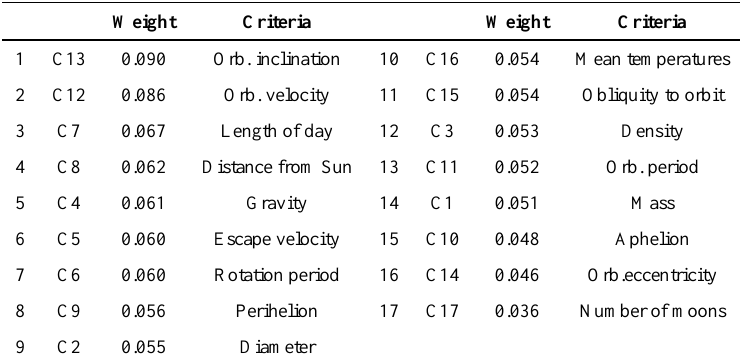
Figure 1. Effect-Direction Graph Diagram Result in DEMATEL Table 4. Criteria weights using